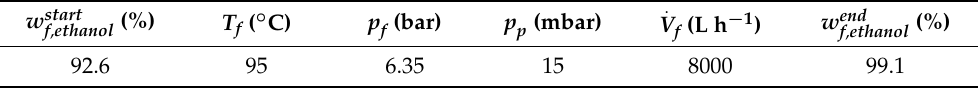
Table 5. Process parameters and ethanol mass fraction after 24 h for the industrial pervaporation plant. 15,000 kg of ethanol/water solution were dehydrated, resulting in a total permeate mass of 1070